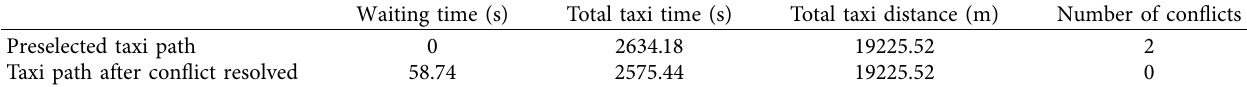
Table 4: Comparison of the results of taxi path planning before and after conflict